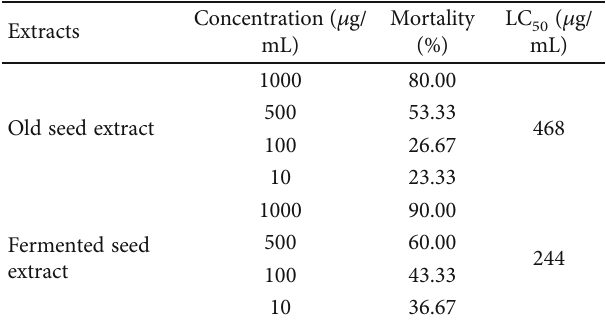
Table 6: LC by the brine-shrimp lethality test of water extract of 50 P. edule